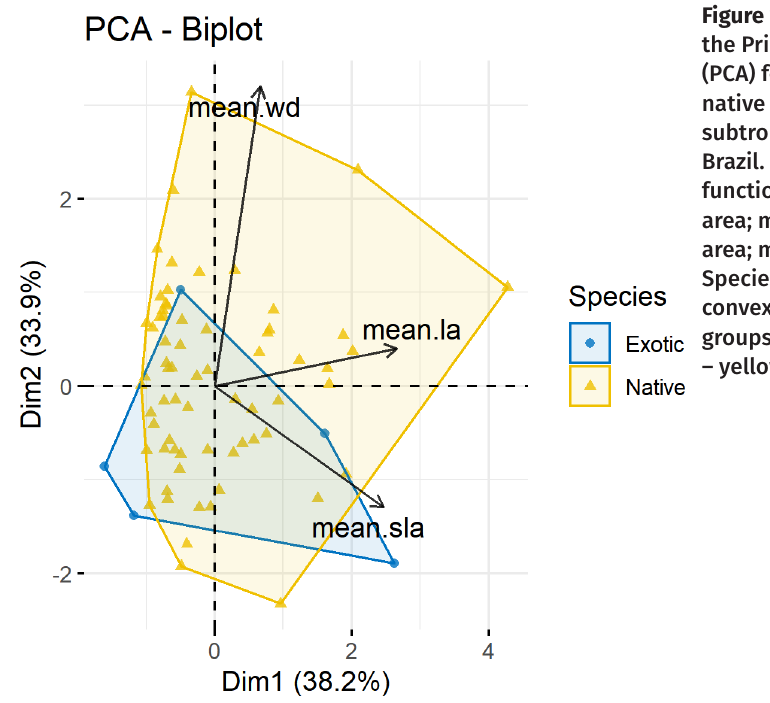
Figure 1. Functional ordination by the Principal Component Analysis (PCA) for a set of native and non- native invasive tree species from the subtropical mixed forest in southern Brazil. Vectors represent continuous functional traits (mean.la= mean leaf area; mean.sla= mean specific leaf area; mean.wd= mean wood density). Species ordinations delimited by the convex hull according to the origin groups (non-native – blue; native –